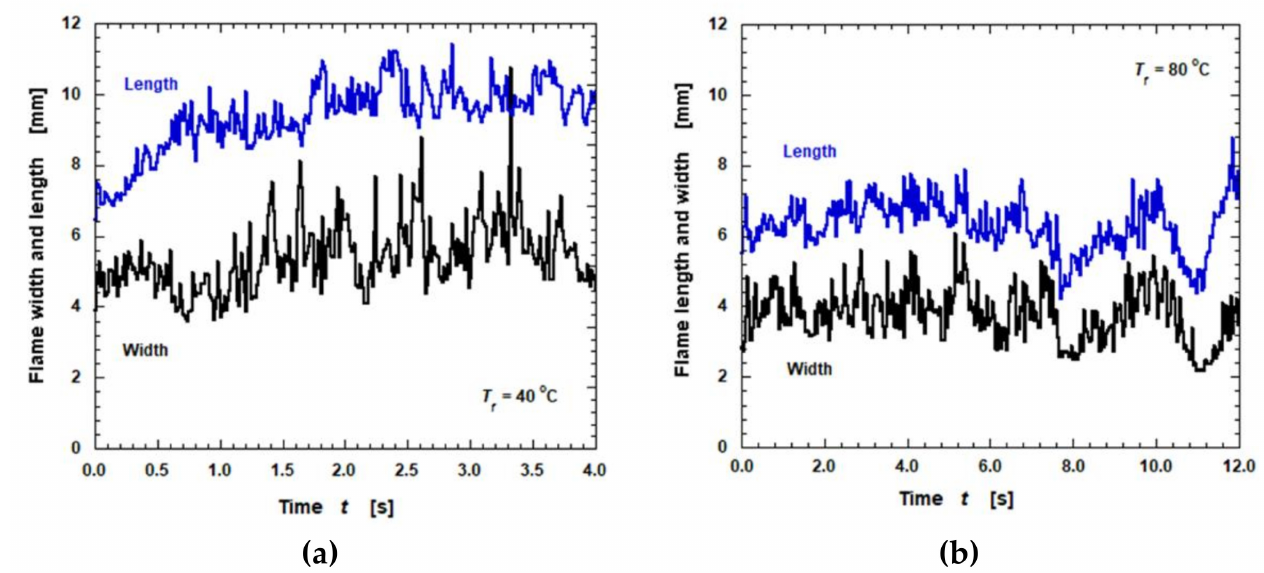
Figure 8. Temporal changes in flame width and flame length when T f equals ( a ) 40 ◦ C; ( b ) 80 ◦ C. Each is a representative case of SEG and